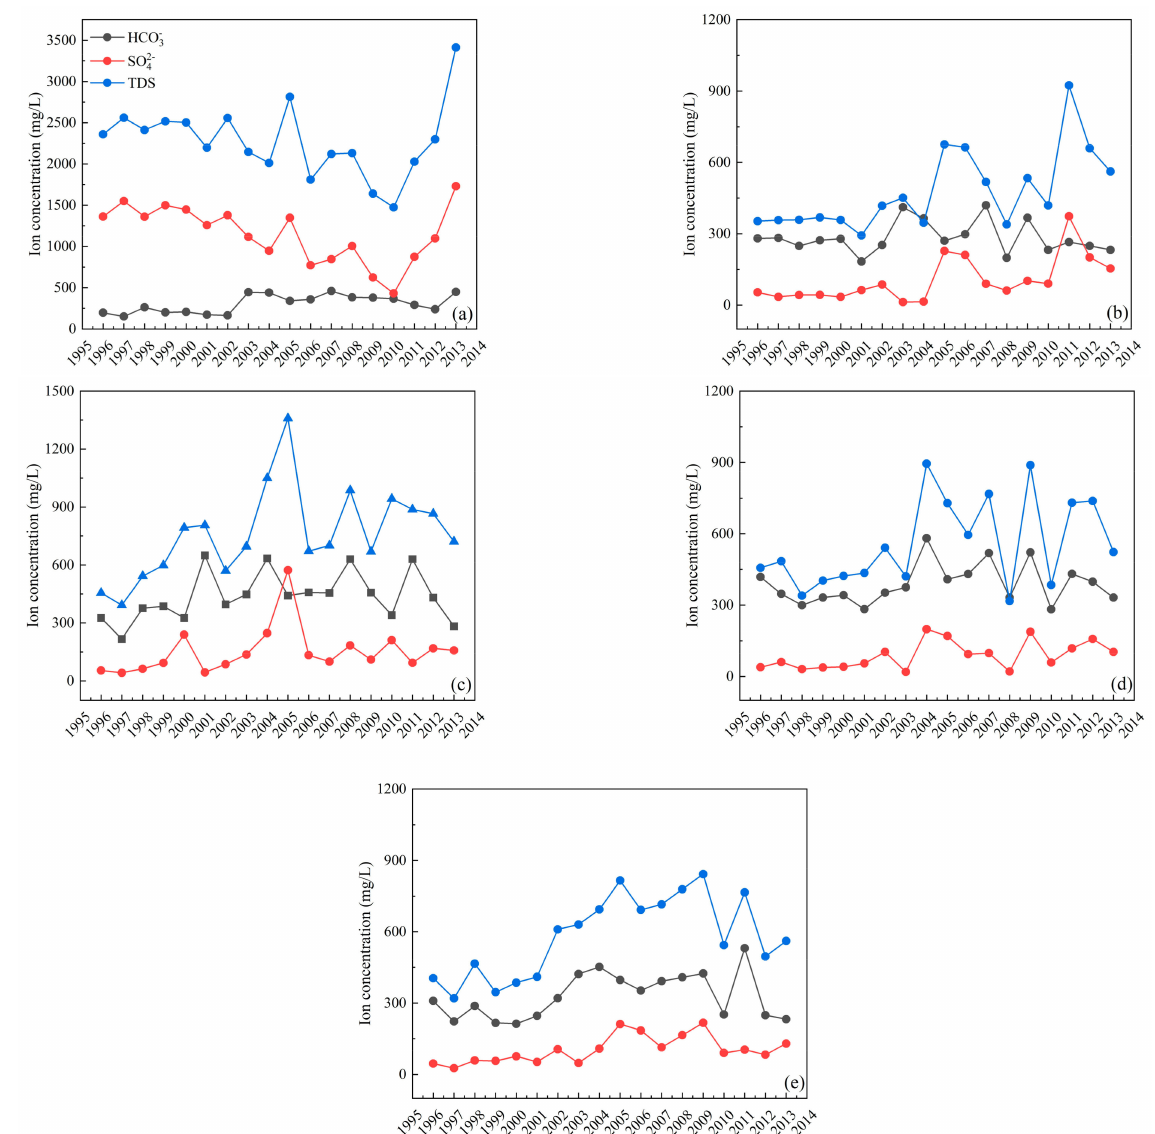
Figure 7. The ion concentration of groundwater sampling points changes over the years (( a ), N17 sampling sites are located in the northwest region; ( b ), N01 sampling points located in the canal head area; ( c , d ) are N53, N02 sampling points located in the runoff area, and ( e ), N05 sampling point is located in the funnel